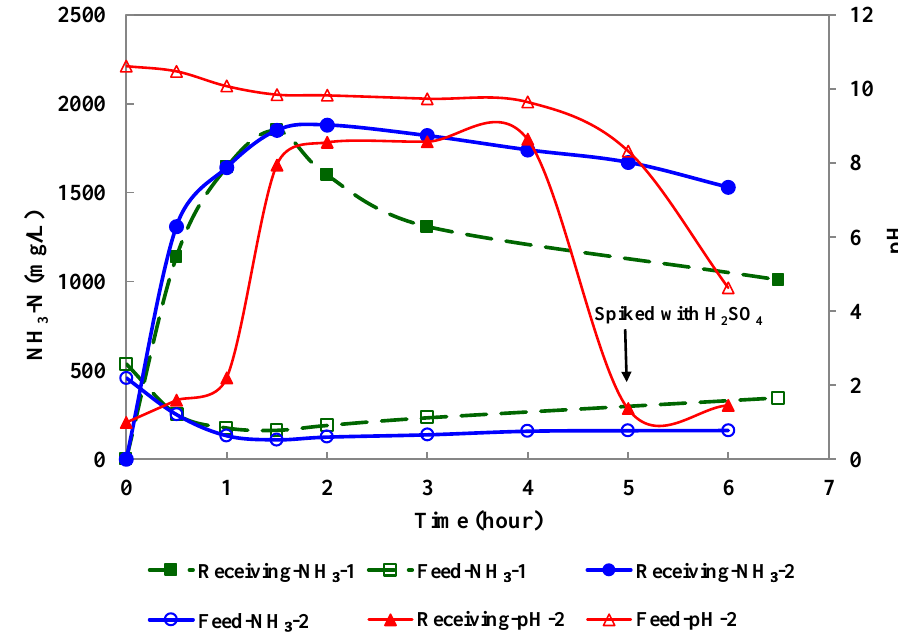
Figure 4. The NH 3 -N concentration in the feed and receiving solution as a function of time using PP hollow fiber membranes.